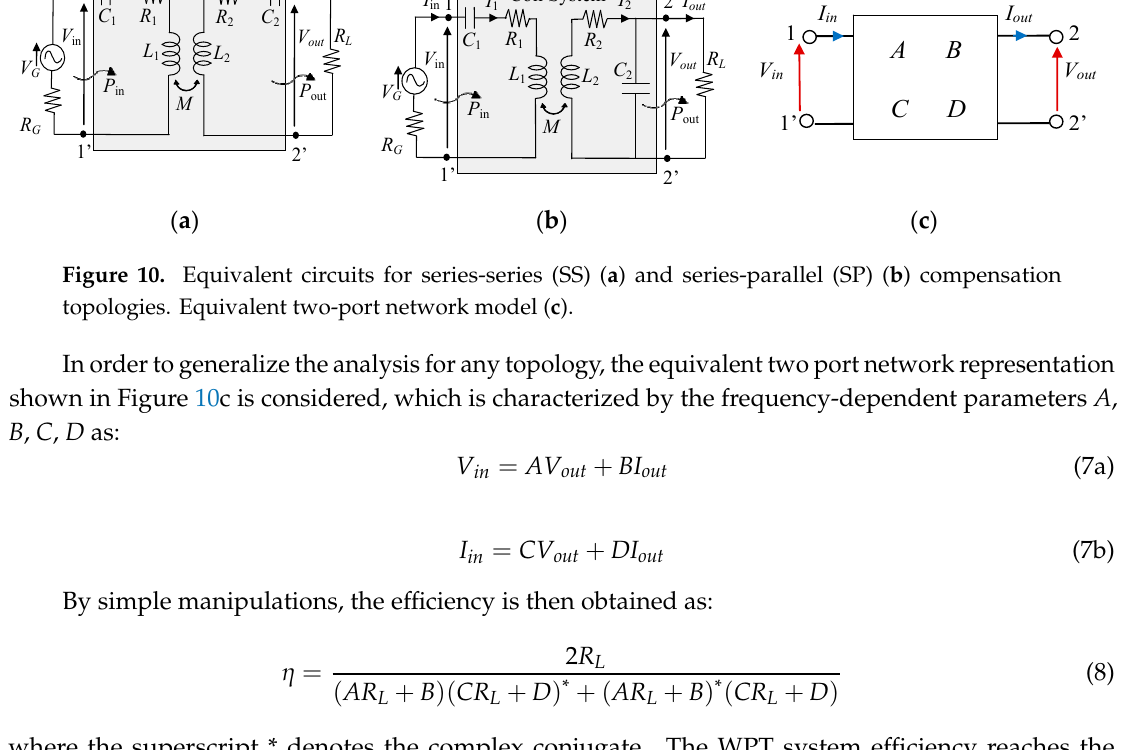
( f ) Figure 9. Magnetic flux lines and B maps in dBT for three housing materials for θ = 0° (silicone ( a ), titanium ( b ), titanium with ferrite cover ( c )) and for θ = 60° (silicone ( d ), titanium ( e ), titanium with ferrite cover ( f )). Table 2. Flux linkage φ in Wb vs angle inclination and materials. Angle θ